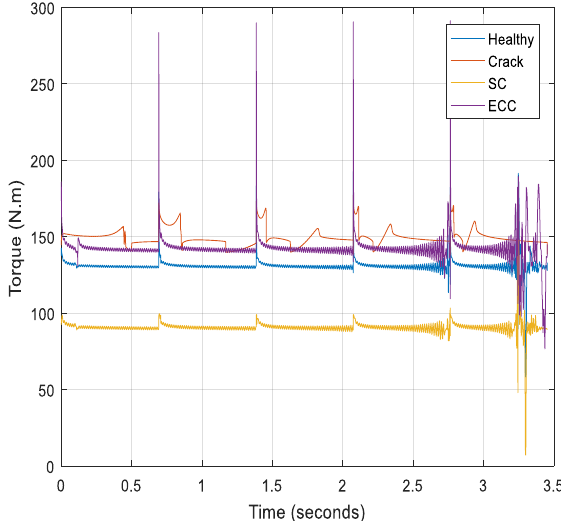
Figure 7. Torque versus time for the different states of the machine. Table 2. Average torque for the different states of the machine.